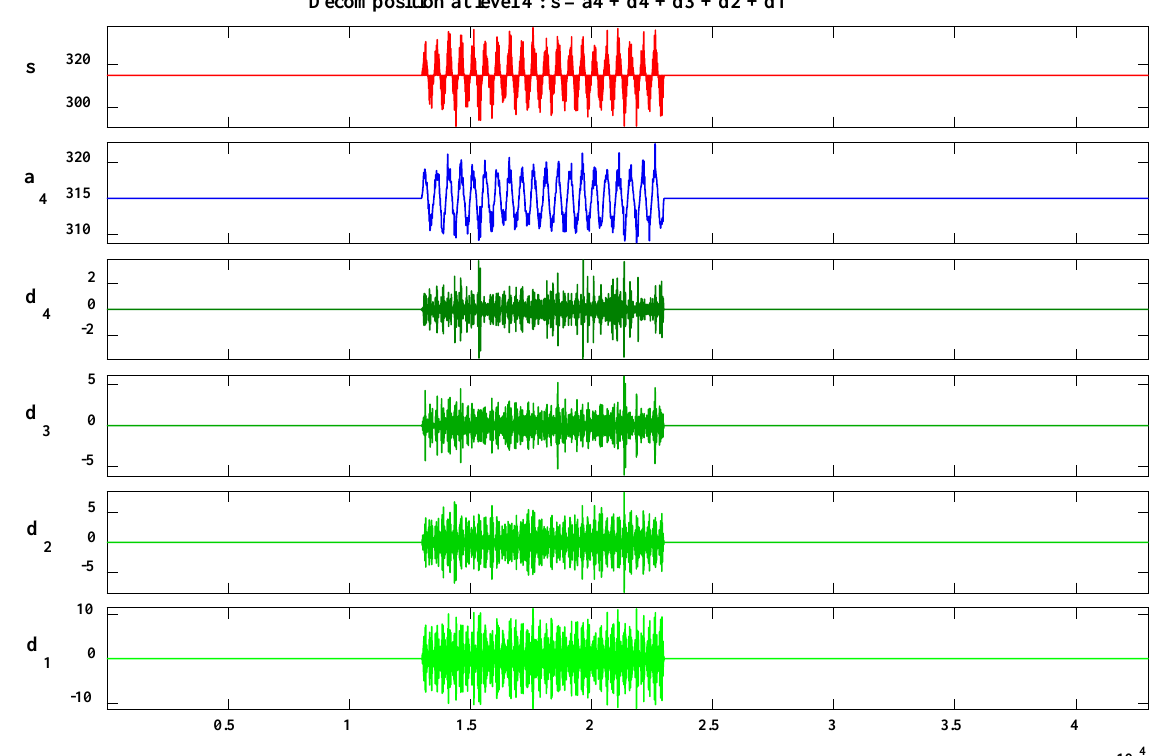
Figure 7. FDIA according to combining a noise to voltage reference waveform: ( a ) Voltage waveform, ( b ) Wavelet Figure 7. b) Wavelet decomposition.